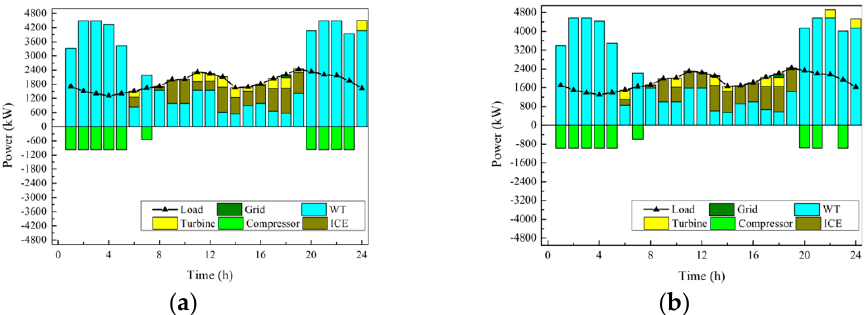
Figure 13. Operational power of electricity in winter: ( a ) without considering off-design characteristics; ( b ) considering off-design characteristics.